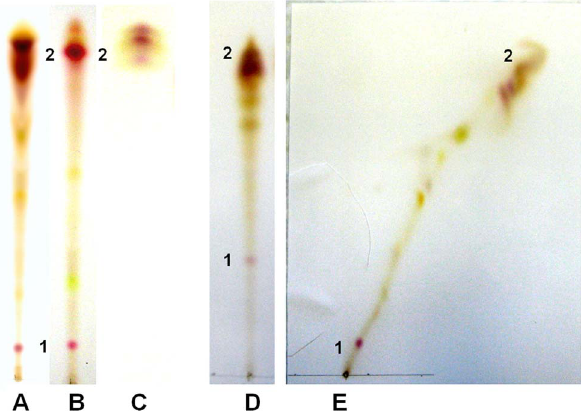
Figure 7. TLC of pink pigments. Columns A and B were extracted pigments from C. neoformans var. neoformans ; pink pigment 1 was water insoluble and pink pigment 2 was water soluble. Column C shows the extracellular water soluble pink pigment 2 produced by C. neoformans var. grubii. Columns D and E (two dimensional TLC) were the extracted pigments from C. gattii. The solvent was 75% methanol, pH 4 to 5. The acid pH solvent developed the pink intracellular water soluble pink pigment, 2. The molecular weight of both the extracellular or intracellular pink pigment, 2, was 535.2 for each Cryptococcus spp.